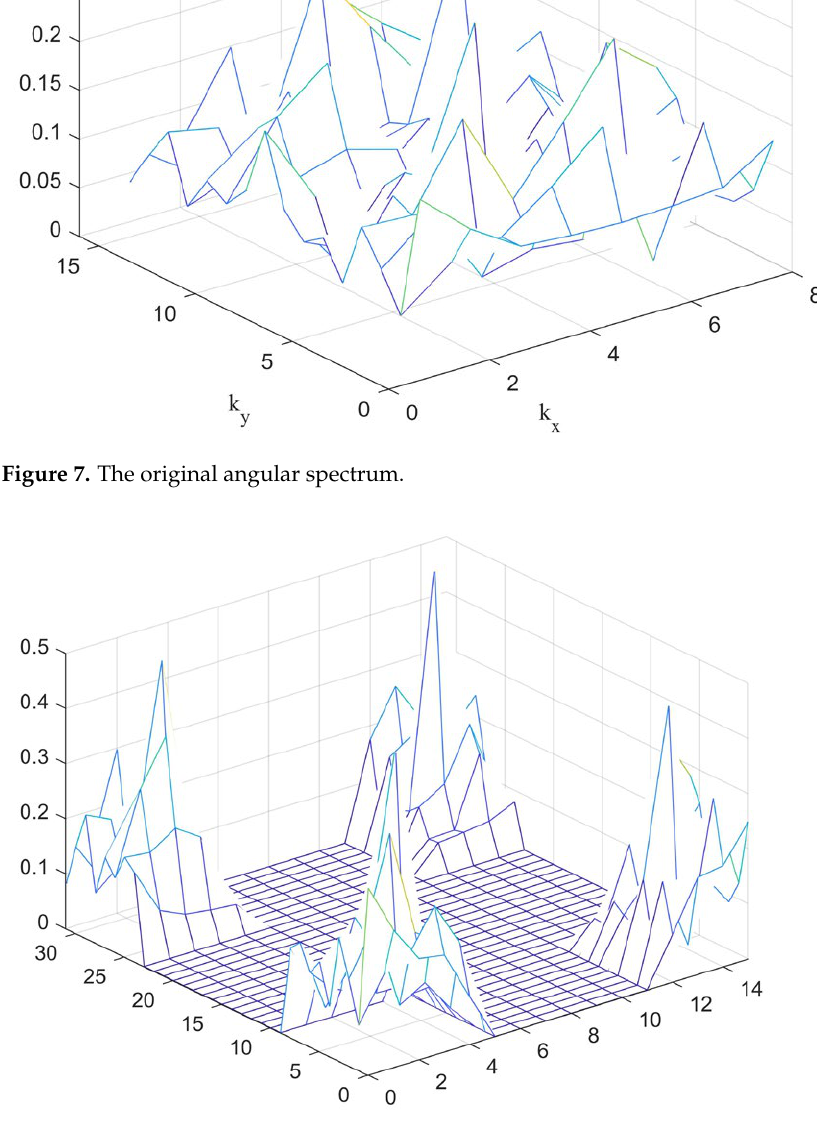
Figure 8. Generated angular spectrum after one zero-padding. IDFT is applied to the angular spectrum after one zero-padding to produce two- dimensional discrete data after smoothing shown in Figure